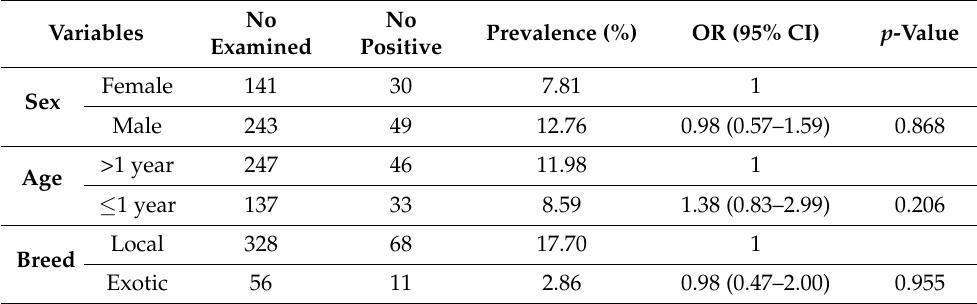
Table 1. Prevalence of Dipylidium caninum infection in dogs and its association with their demographic factors in Bishoftu Town,